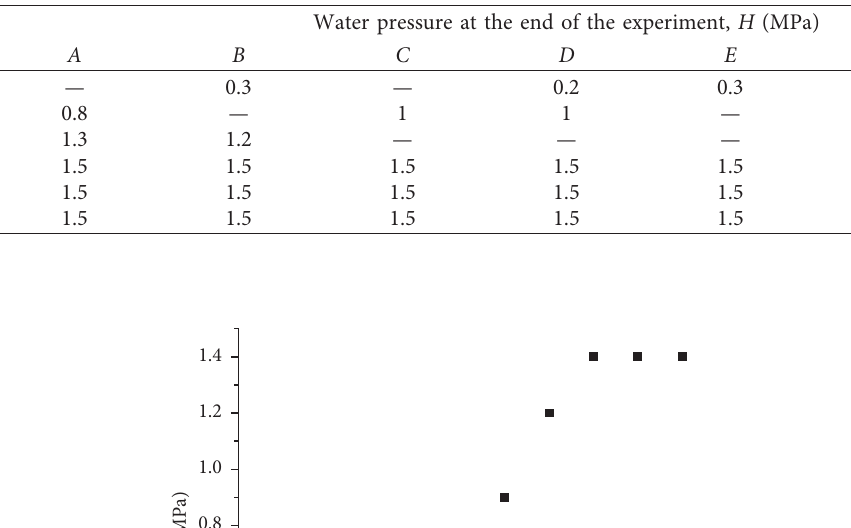
Table 6: Effects of different contents of EP on the water exudation pressure of FC.